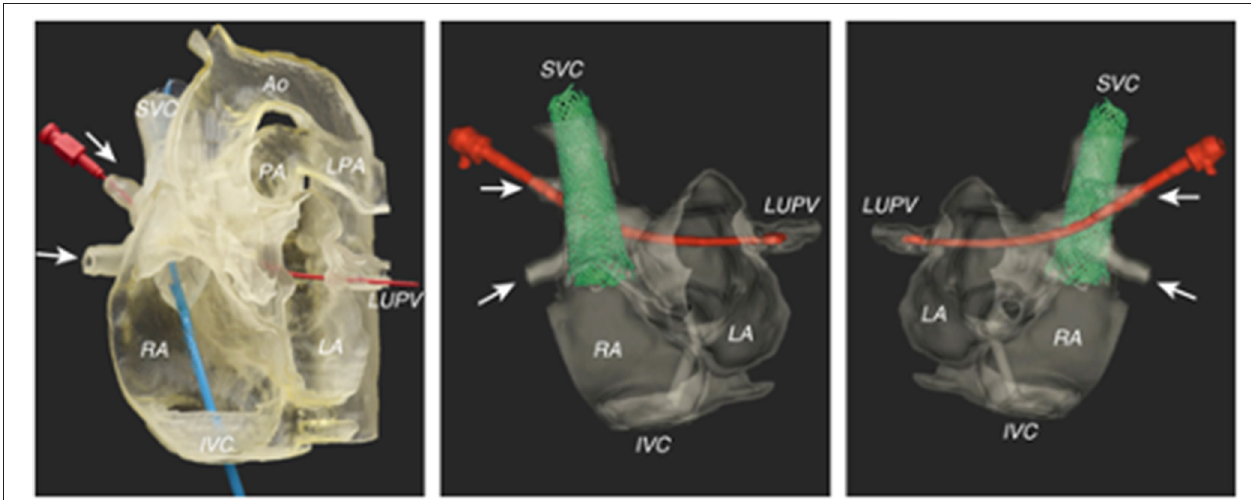
FIGURE 2 | Pre-procedural imaging for sinus venosus ASD using a 3D-printed model for simulation of the stenting procedure. A red probe is inserted in the path of the right upper pulmonary venous drainage to the left atrium. Images reproduced with permission from Velasco Forte et al. (30).